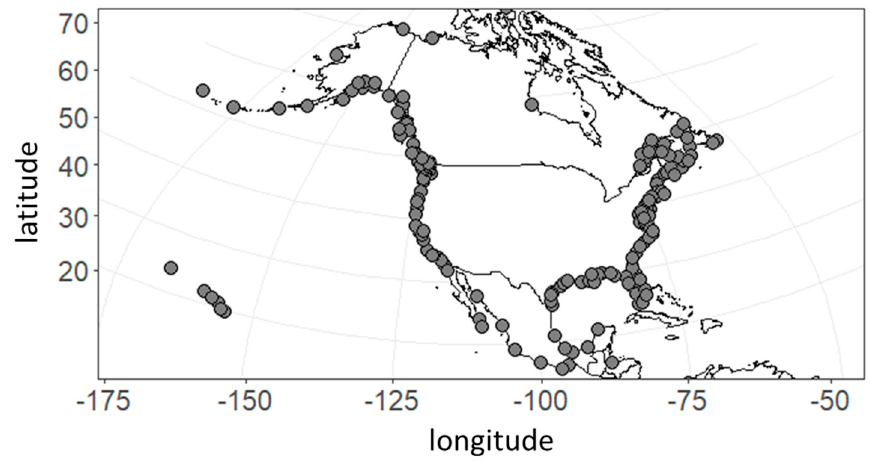
Figure 2. Locations of Permanent Service for Mean Sea Level (PSMSL) [49] sea level stations used throughout North America and Mexico.